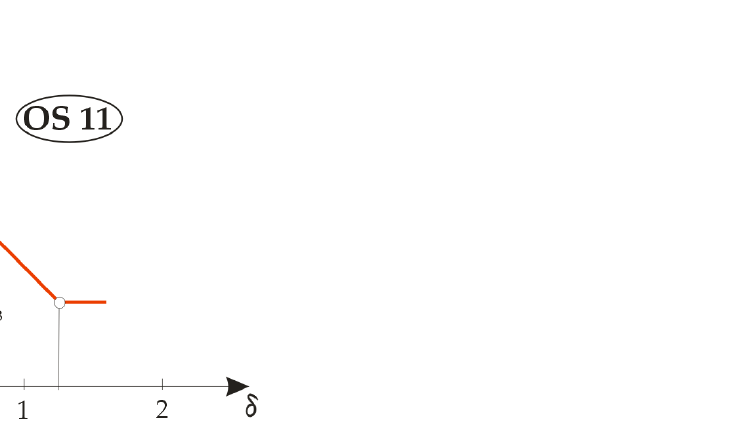
Figure 7. Graphical representations of the temperature gradients for built-in materials.